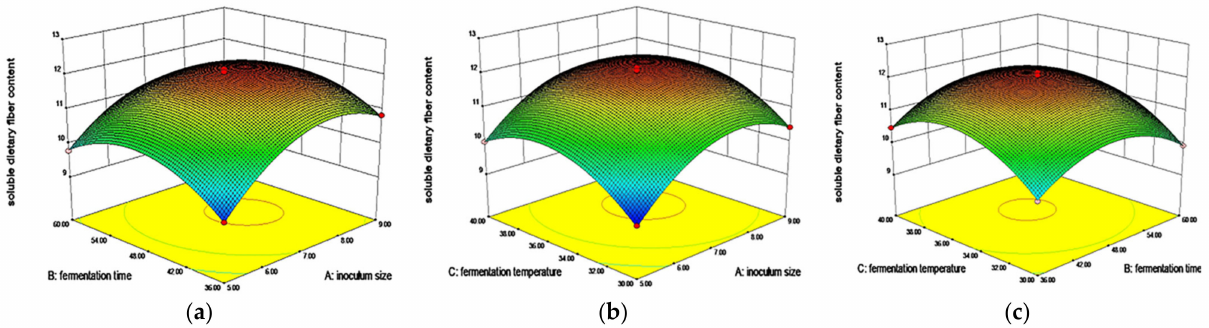
Figure 3. Effects of ( a ) inoculum size and fermentation time, ( b ) inoculum size and fermentation temperature, and ( c ) fermentation time and fermentation temperature on SDF